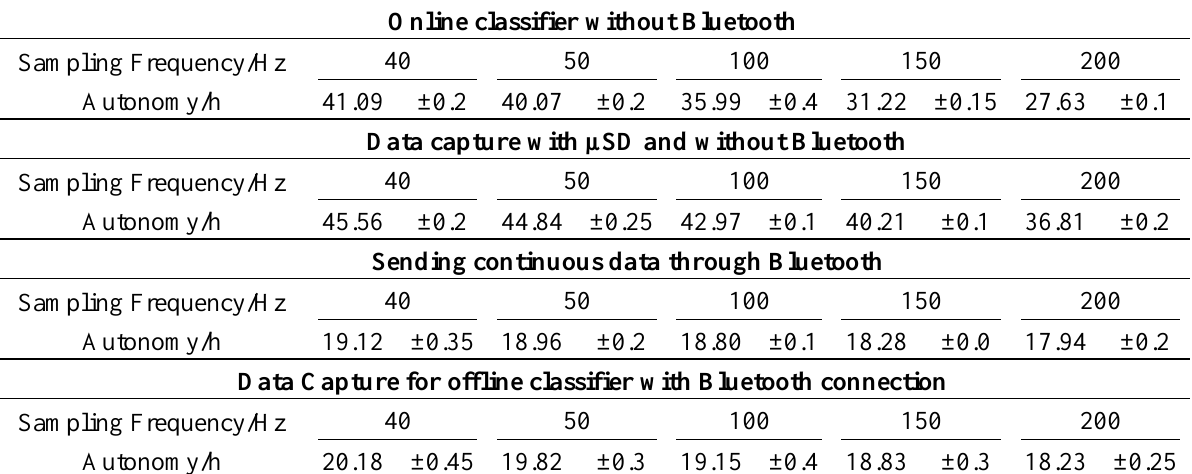
Table 3. Operating mode